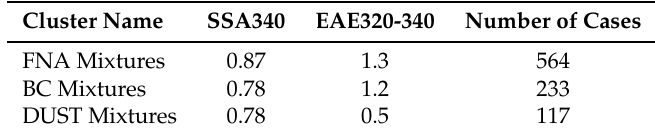
Table 2. The mean SSA440 and EAE320-340 values per Brewer reference cluster are included here.